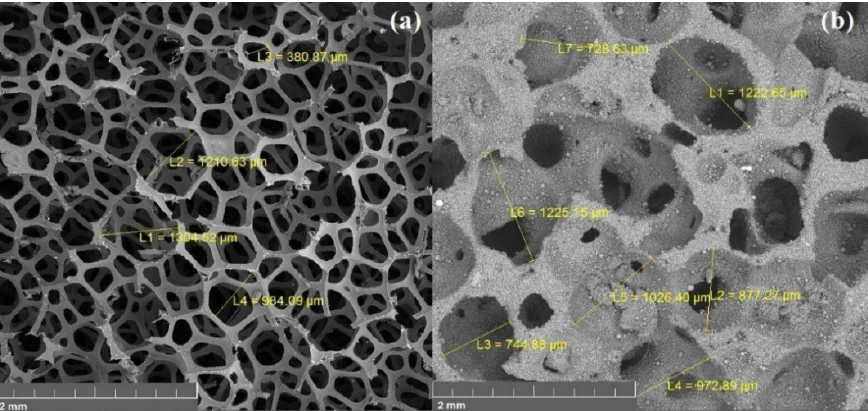
Figure 6. SEM image of PU sponge ( a ) and obtained foam by replication technique ( b ).